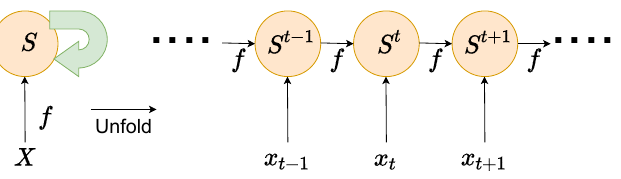
Figure 5. RNN architecture with no output: the network has feedback connections which can be unfolded in time and trained using back-propagation. The input X is processed by incorporating it into the state S that is passed forward through